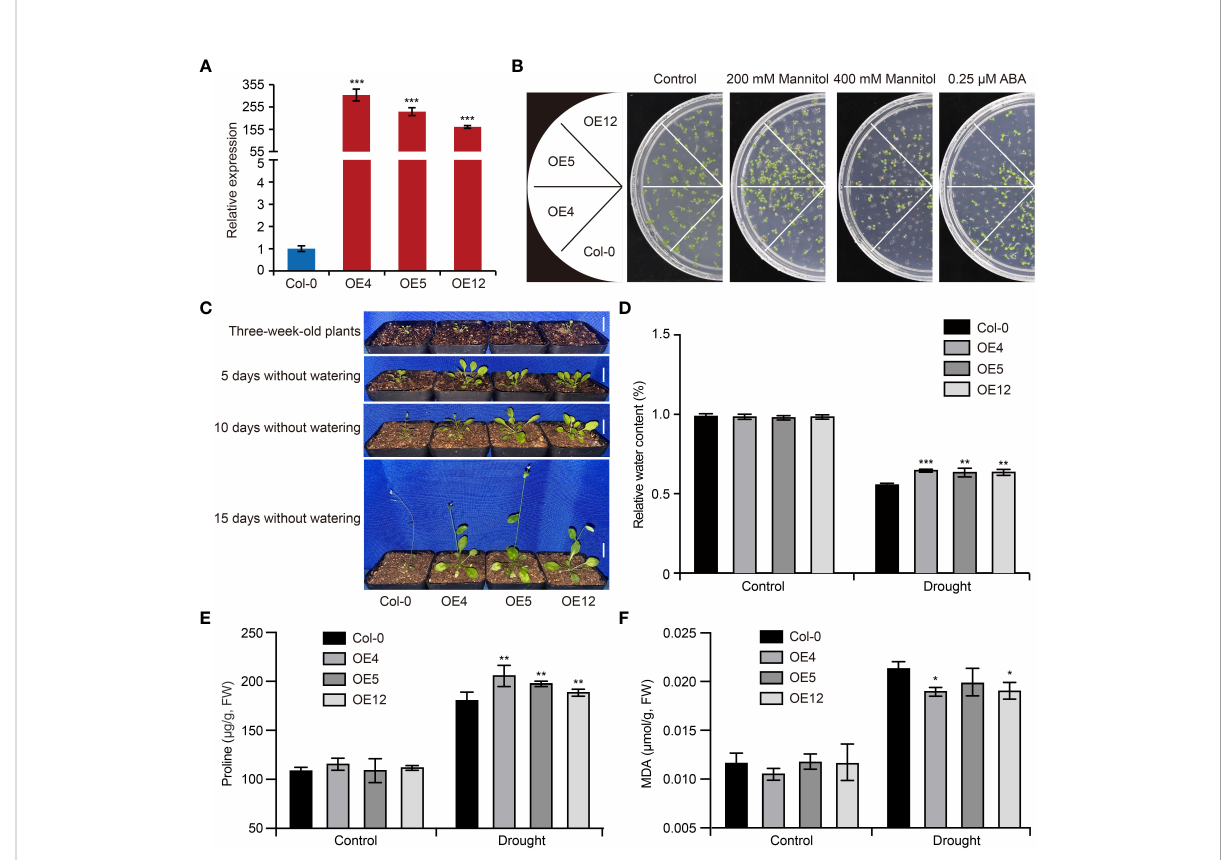
FIGURE 4 Overexpression of GhCDPK60 increases drought tolerance in Arabidopsis . (A) The expression level of overexpressed- GhCDPK60 in Arabidopsis . Col-0, wild-type Arabidopsis ; OE4, OE5 and OE12, three independent lines. (B) Seed germination of Col-0 and GhCDPK60 -overexpressing Arabidopsis under drought stress and ABA treatments. Seeds were germinated on 1/2 MS agar plates with or without ABA and mannitol. Photographs were taken 10 days after 0.25 m M ABA, 200 mM or 400 mM mannitol treatments. (C) Phenotypes of Col-0 and transgenic lines after drought treatment. Three-week-old seedlings were deprived of water for 5, 10 or 15 days. Bars = 1 cm. (D) Relative water content of Col-0 and transgenic lines with or without drought treatment for 15 days. (E, F) The analysis of proline (E) and MDA (F) concentrations of leaves in Col-0 and GhCDPK60 -overexpressing lines after drought stress treatment. Statistically signi fi cant differences compared to Col-0. Values represent the mean ± SE from three biological replicates. * P < 0.05, ** P < 0.01 and *** P < 0.001 by Student ’ s t